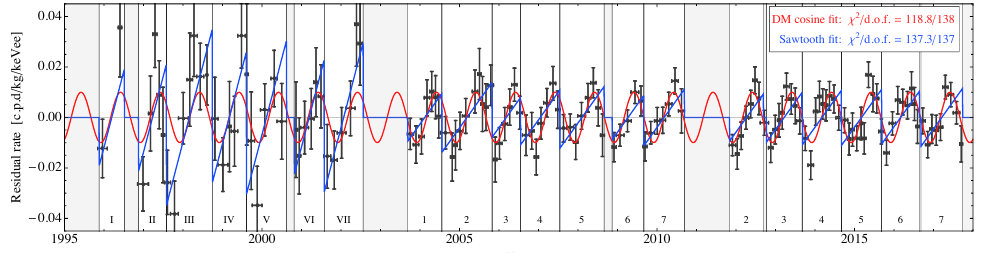
Figure 5 . The black data points are the DAMA residuals in the (2{ 6) keVee energy window, taken from [1, 6]. The curves are (cid:12)ts to a cosine annual modulation peaked on June, 2nd (red curve), as expected for a DM signal, and to the irregular sawtooth obtained from a continuously growing background (blue curve). The roughly annual data-taking cycles of DAMA/ NaI, DAMA/LIBRA Phase 1, and DAMA/LIBRA Phase 2 are shown as vertical